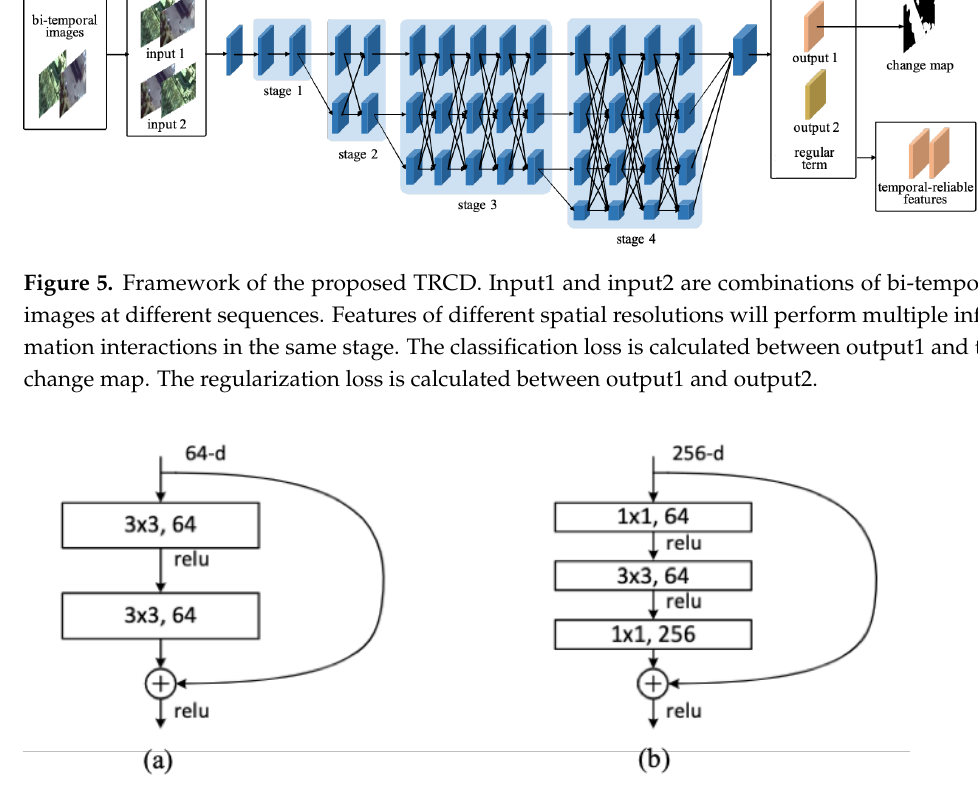
Figure 6. The residual function in our network: ( a ) basic block module, ( b ) bottleneck